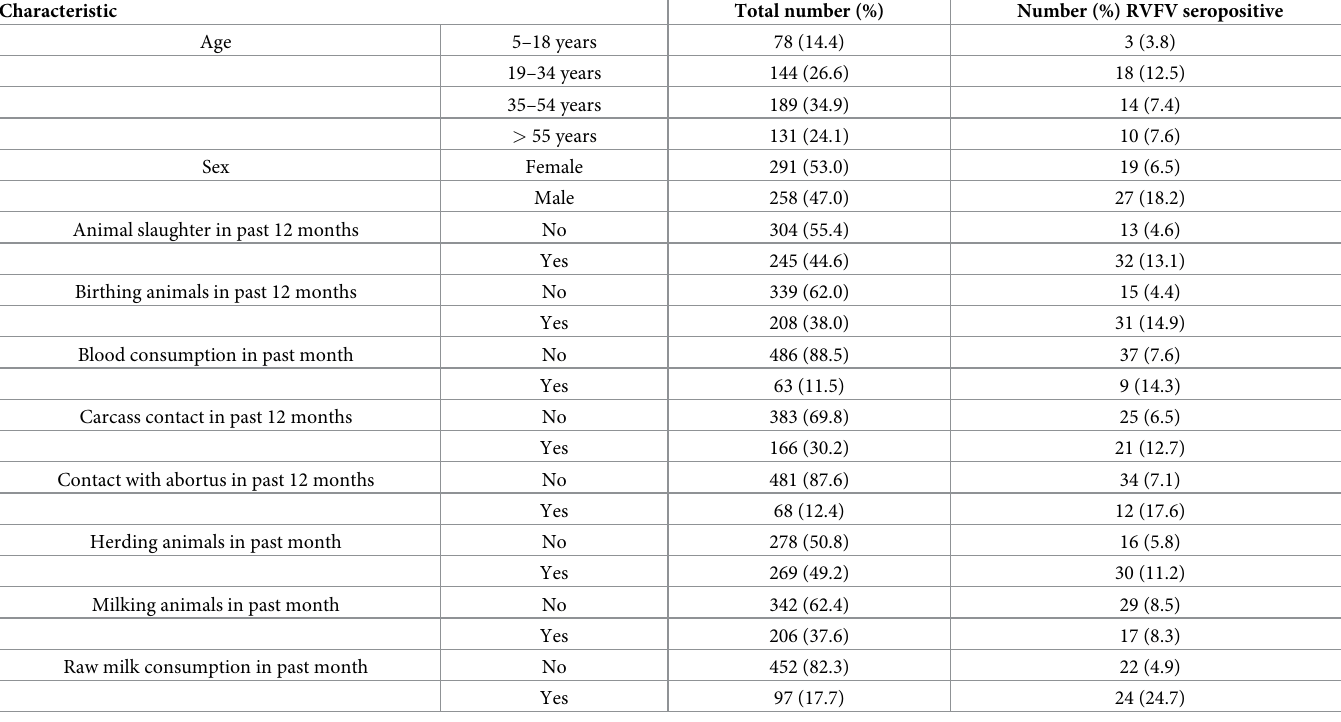
Of the 46 ELISA positive individuals, a random selection of 26 (57%) were tested with the PRNT. All were positive on the basis of this second test. A comparison between ELISA and PRNT results is given in the S1